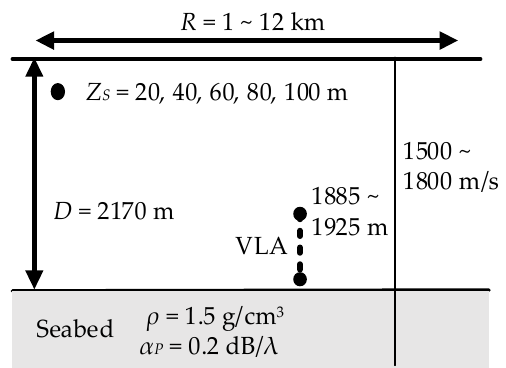
Figure 4. Synthetic ocean environment model, where R represents the range between source and receiver; ZS represents the depth of source; D represents the depth of the sea; ρ and α P represent the density and attenuation coefficient of the seabed, respectively.